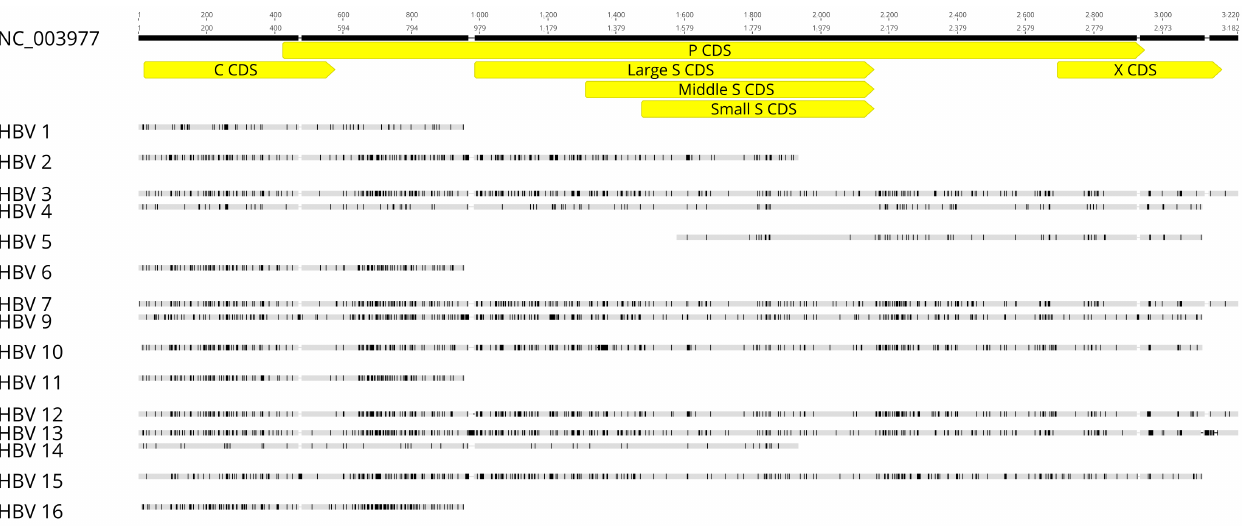
Figure 1. HBV sequences from our samples aligned by MAAFT program. Polymerase, core, X and surface coding sequences are highlighted in yellow boxes. Black bars highlight disagreements between the sample sequence and the reference sequence